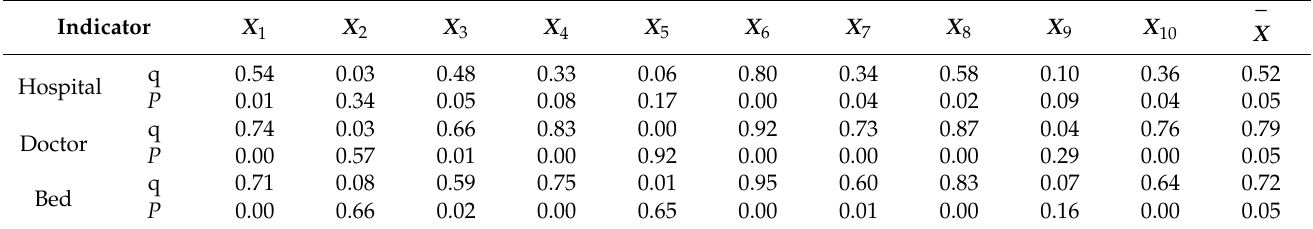
Table 3. Analysis on influence factors of medical resources changes.